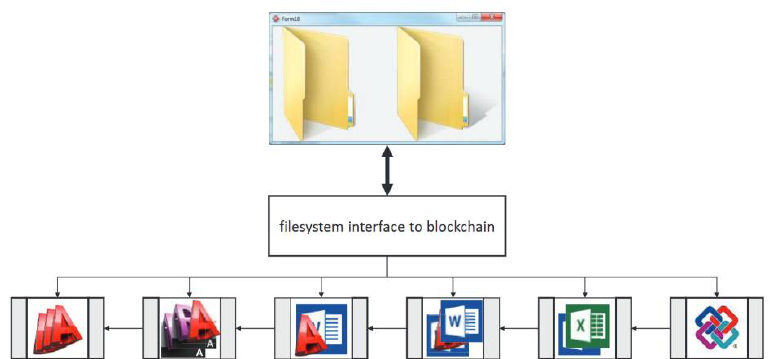
Figure 9. Chained and extremely decentralized management via blockchain. Reprinted/Adapted with permission from Reference [71]. Copyright 2017 Copyright Elsevier Ltd.